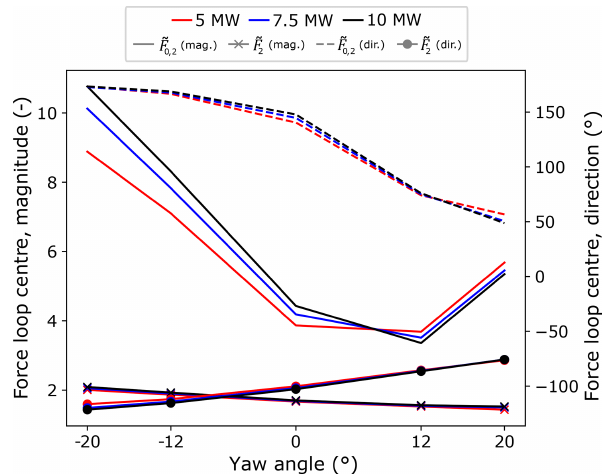
Figure 8. Non-dimensionalised, downwind-row, radial-force-loop- centre magnitude and direction values for overhung ( ˜ F 0 , 2 ) and cen- tred ( ˜ F 2 ) main-bearing configurations across the three modelled tur- bines as the yaw offset is varied.